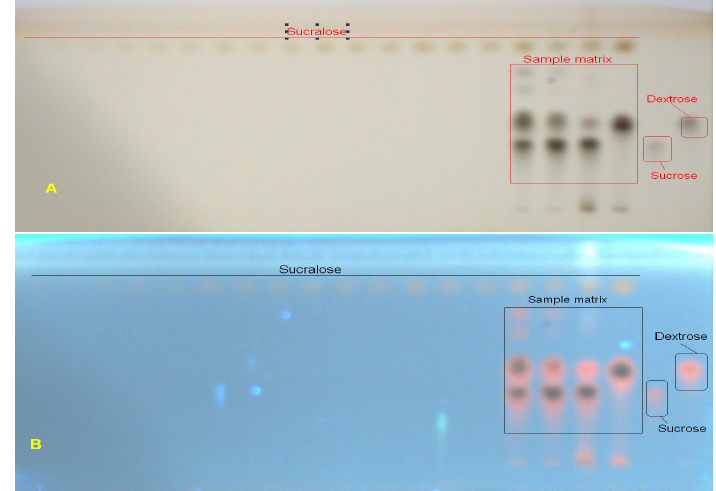
Figure 3. Documentation of plate images (illuminated in reflectance mode) obtained during quantification of sucralose. (A) 456 nm (B) 366 nm after derivatization with rhodamine-sulfuric acid (Solvent system-I)